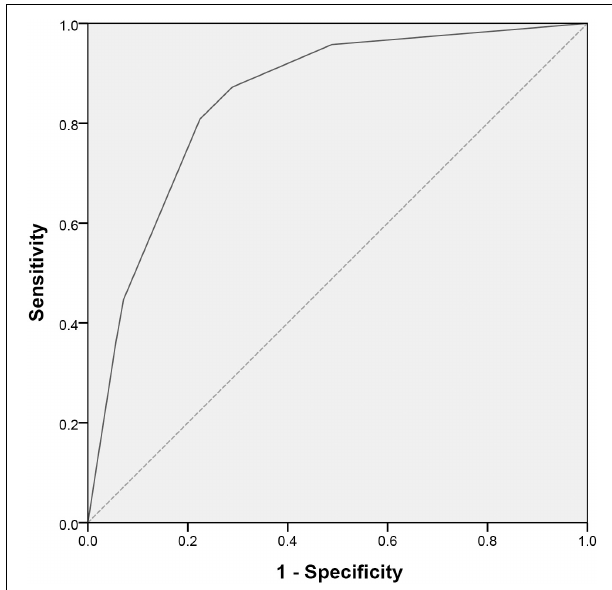
FIGURE 2 | ROC curve for scoring model between IVIG-resistant and IVIG-sensitive KD children. The X and Y axes of the curve represent the predicted false positive rate (1-specificity) and sensitivity, respectively. The dashed line indicates equal true and false positive rates, meaning no predictive value. The solid line is the ROC curve to predict IVIG-resistant KD. A region formed by the ROC curve and the X-axis is called the AUC and its value is 0.850 (95% CI: 0.798–0.901; P < 0.001). ROC, receiver operating characteristic; IVIG, intravenous immunoglobulin; KD, Kawasaki disease; AUC, area under the curve; CI, confidence interval.